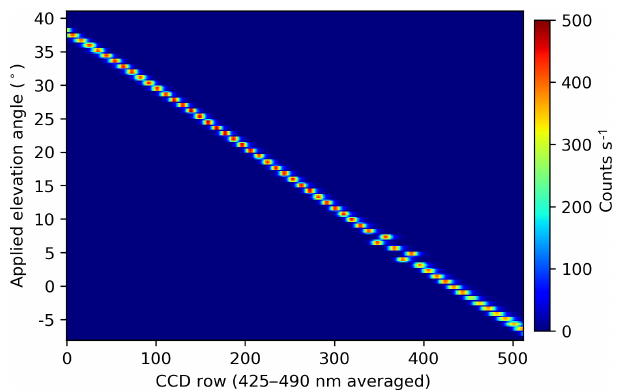
Figure 4. Elevation angle calibration matrix: the intensity in the fitting range is displayed as function of the CCD row ( x axis) and telescope elevation angle ( y axis).